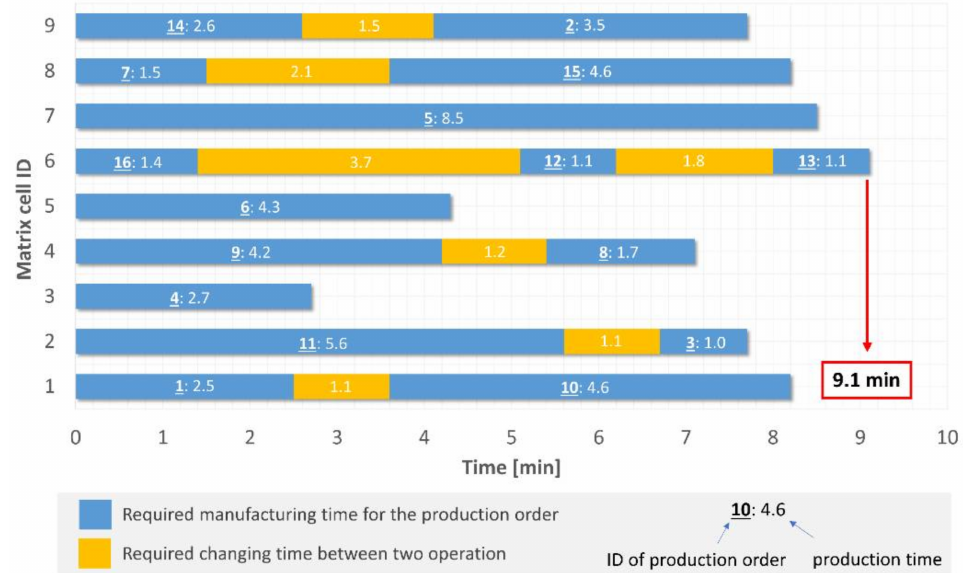
Figure 3. Gantt chart of the working process resulting from the optimal assignment of production orders to matrix cells in scenario A.